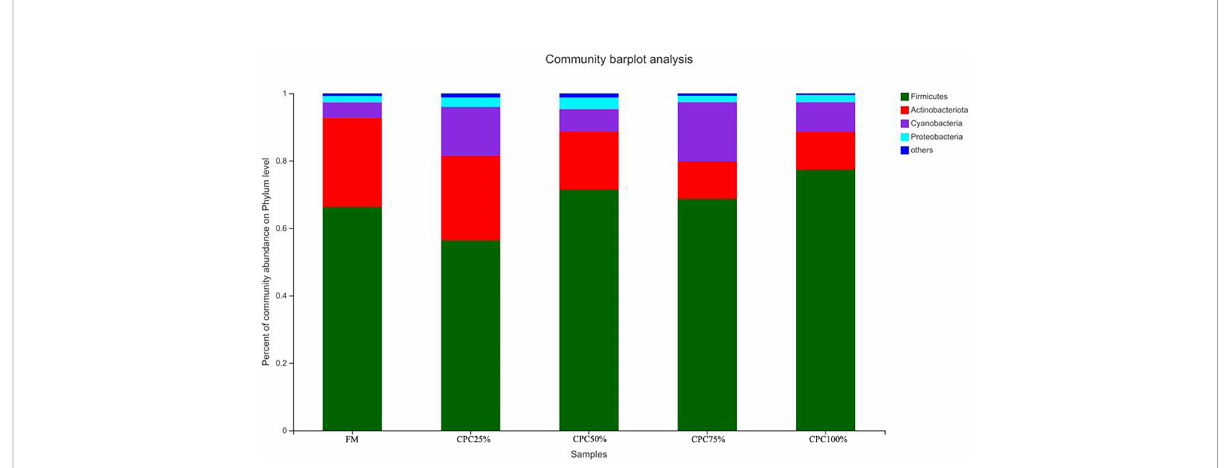
FIGURE 7 Effects of fi shmeal replacement by cottonseed protein concentrate on relative abundance of intestinal microbes in juvenile rainbow trout at the phylum